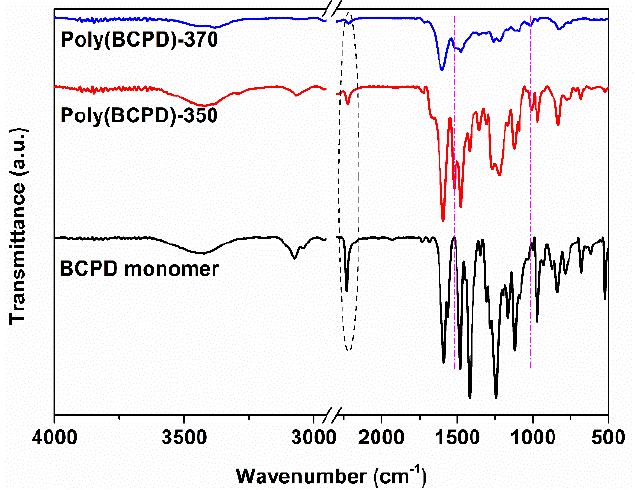
Figure 8. FT-IR spectra of BCPD monomer and poly(BCPD) resins.